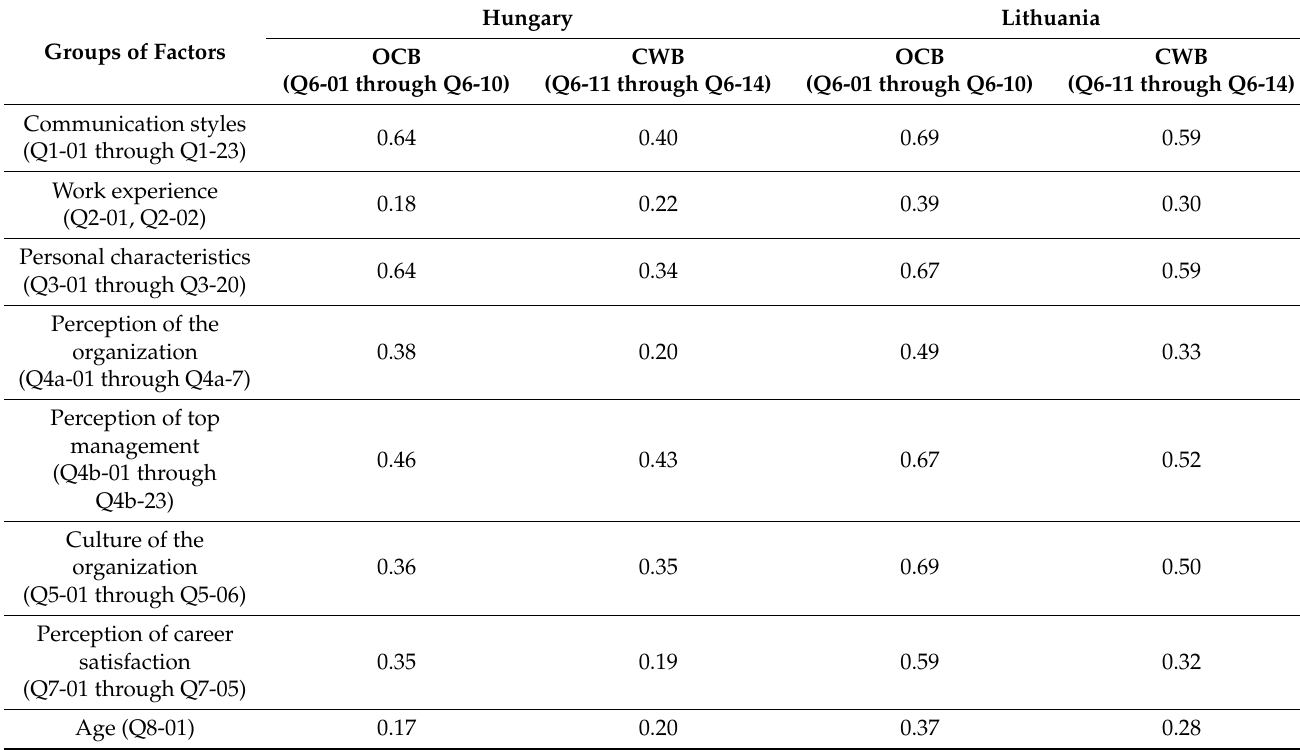
Table 2. Canonical correlations among the